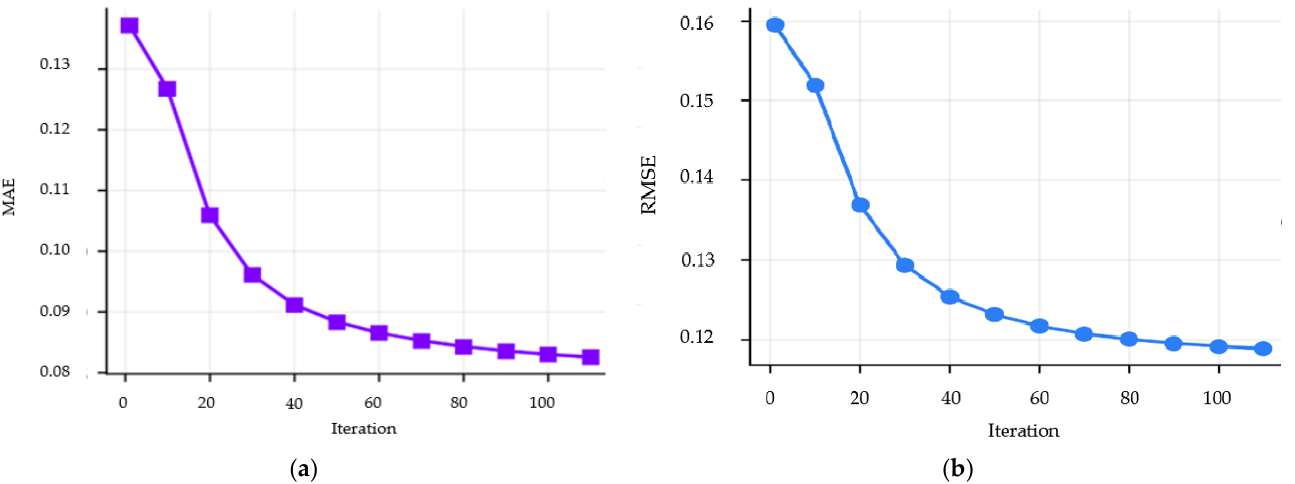
Figure 3. ( a ) Impact of the number of iterations on MAE; ( b ) Impact of the number of iterations on RMSE.